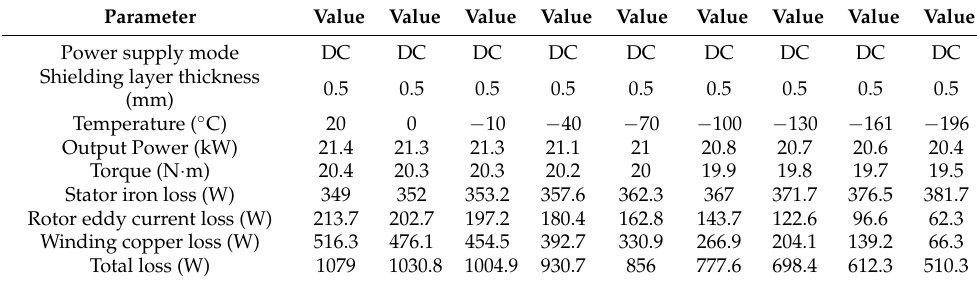
Table 4. Motor-loss data at various